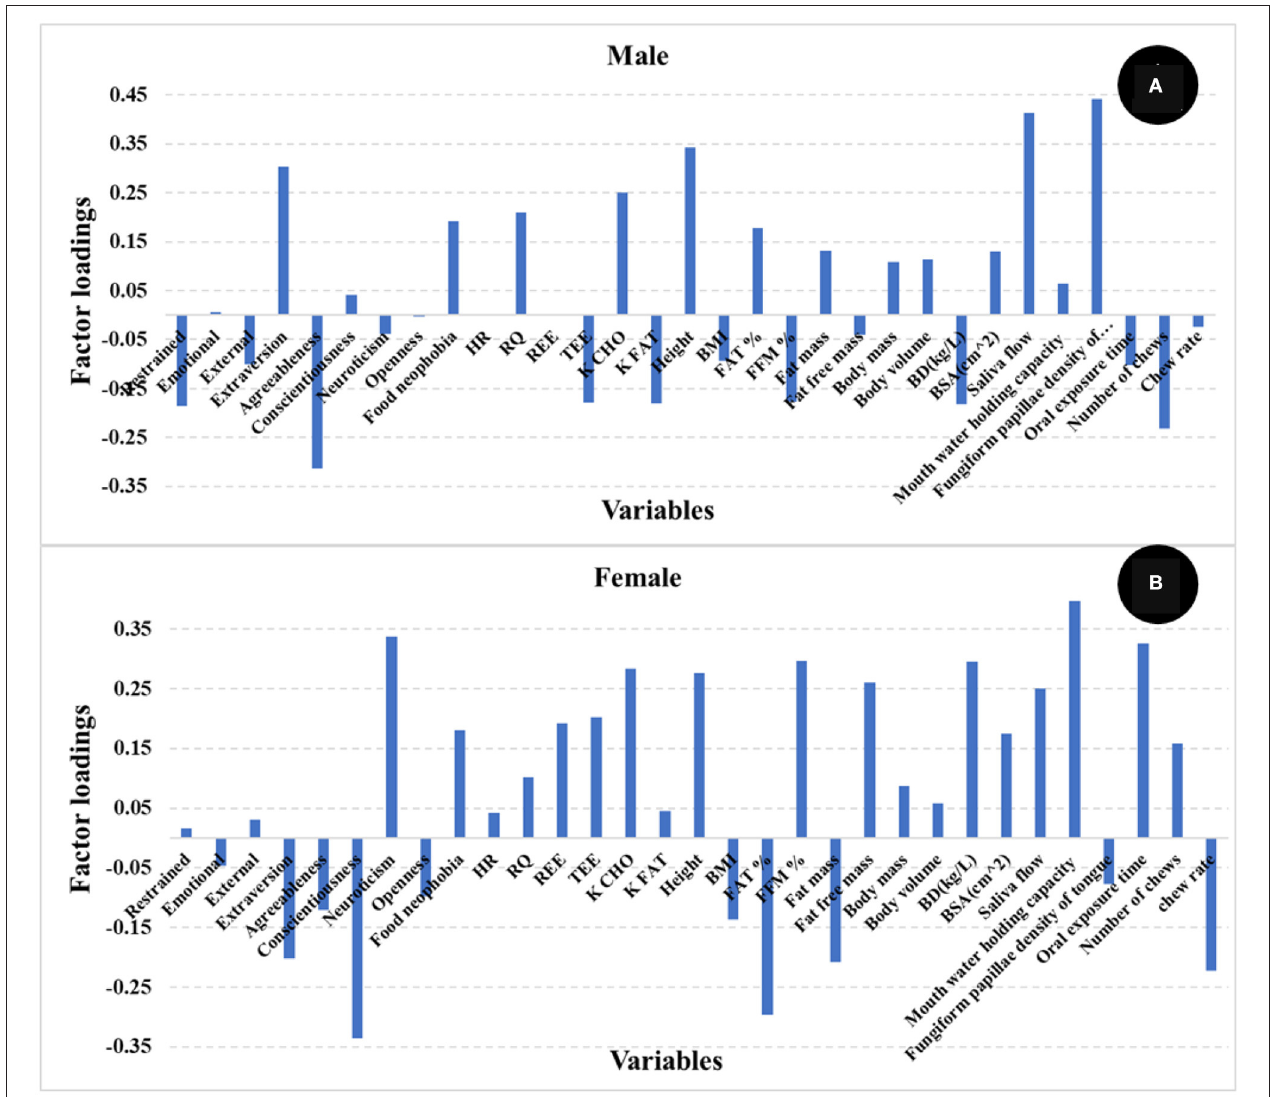
FIGURE 5 | Loadings for PLS regression models comparing male (A) and female (B)